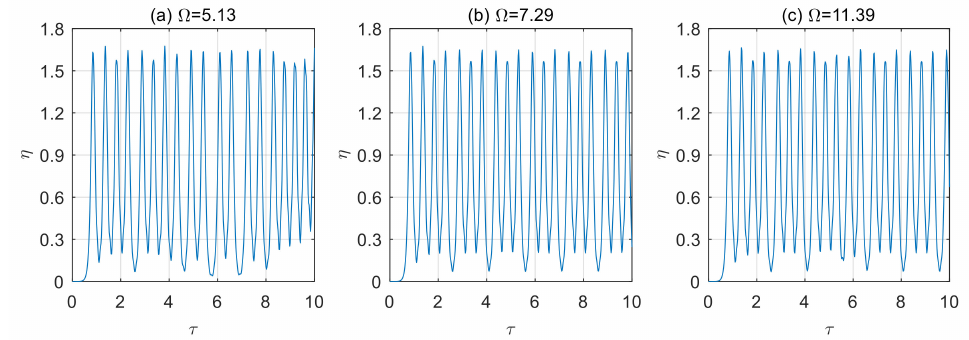
Figure 12. Displacement time history diagram of microtubes with different dimensionless frequencies of excitation loads ( u = 8). ( a ) Ω = 5.13; ( b ) Ω = 7.29; ( c ) Ω =